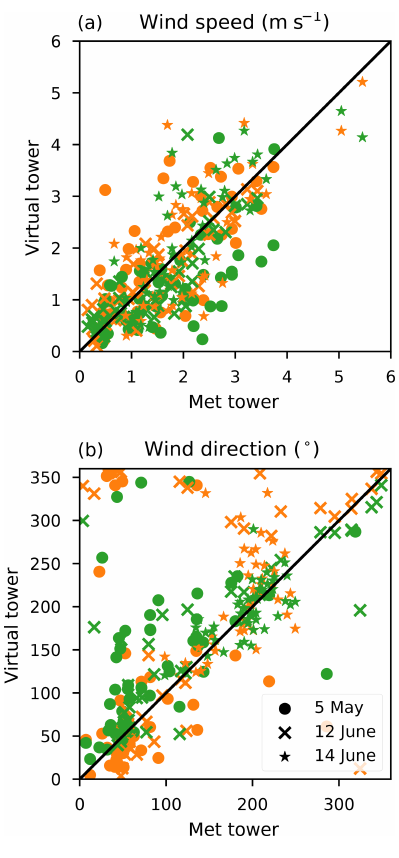
Figure 10. Scatter plots of the wind speeds (a) and direction (b) from VT2 (green) and VT3 (orange) vs. the 5min averages of wind speed and direction from Tower